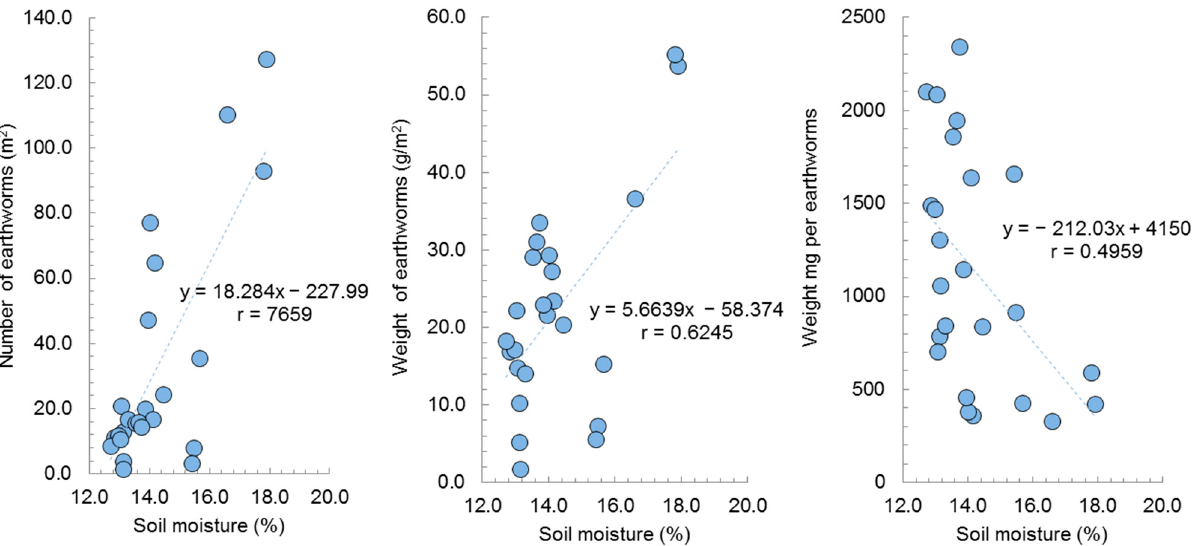
Figure 7. Mean soil temperature and moisture of spring samples in the third year of the trial along with the soil profile at depths from 0 to 60 cm. according to different soil management practices. Different letters denote significant differences among soil management practices in each depth ( p ≤ 0.05).